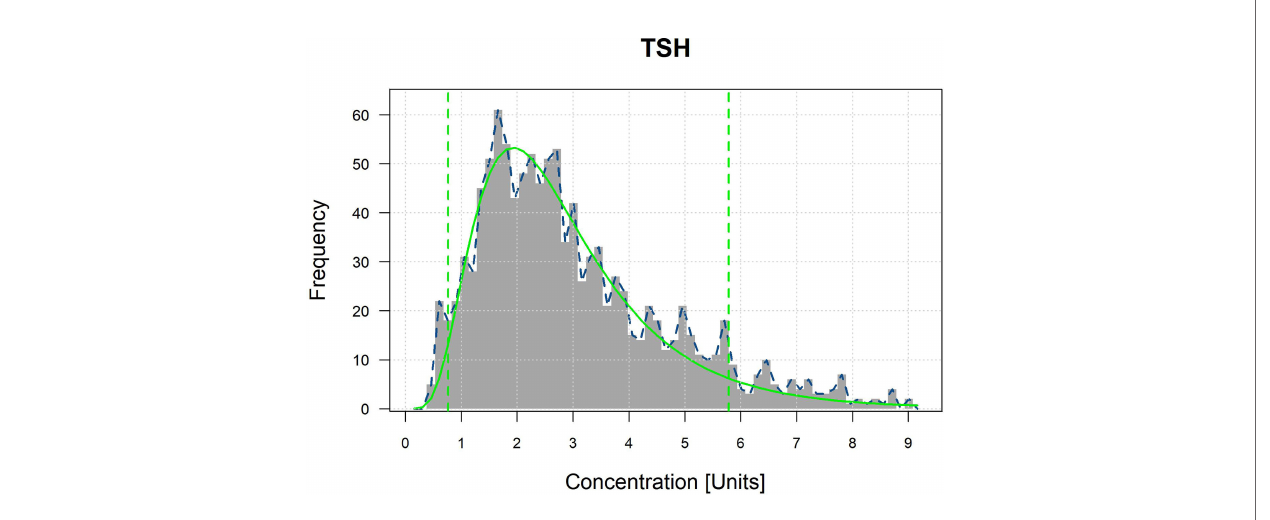
FIGURE 2 | Optimal parametrical models calculated by re fi neR algorithm for TSH.